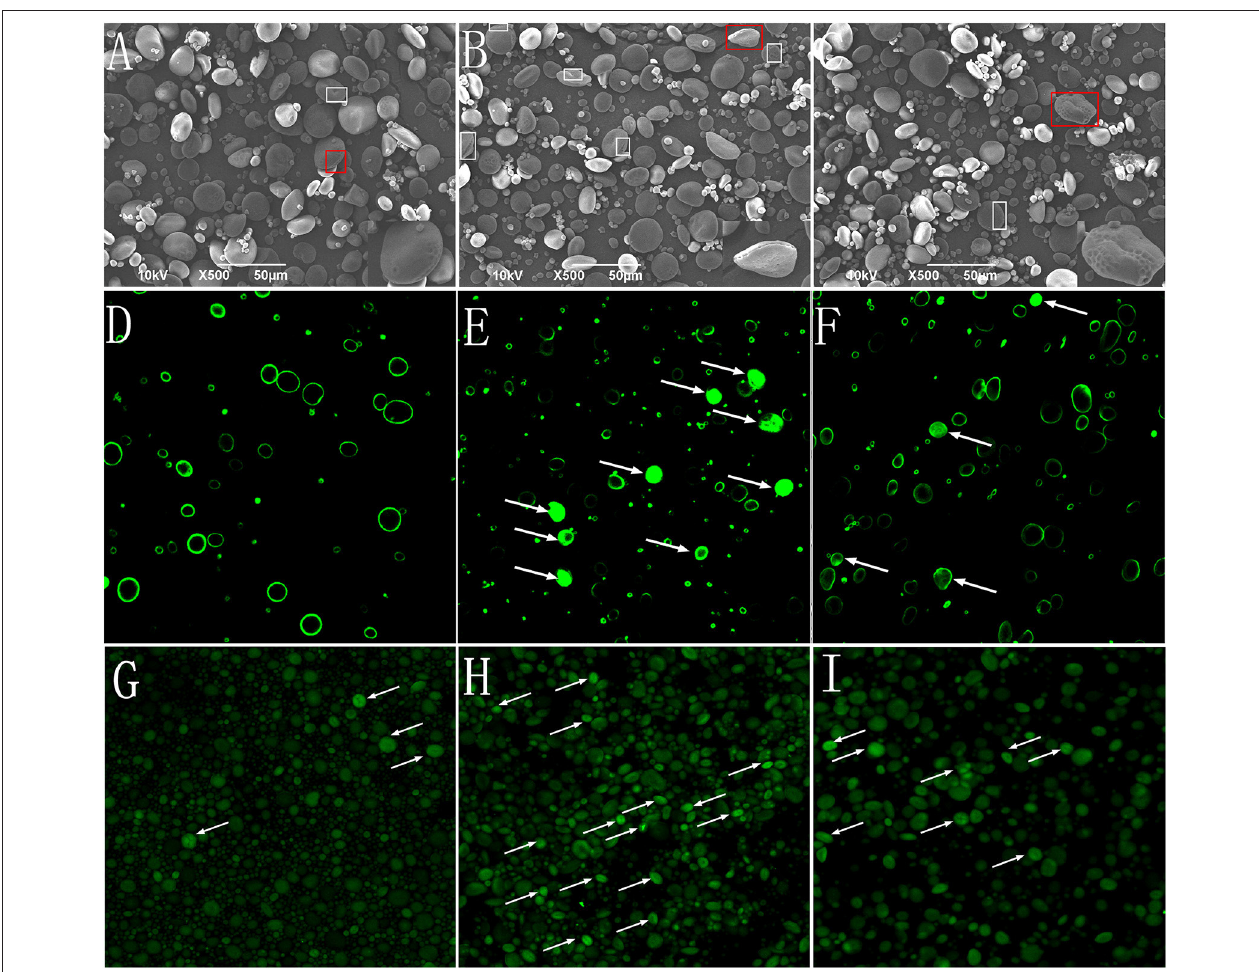
FIGURE 2 | Starch granules isolated from mature wheat seeds (35 days post anthesis) and observed using SEM ( × 500 magnification) and CLSM ( × 400 magnification). Starch granules were isolated from the wheat grain in the 0kg P ha − 1 (P0) treatment (A,D,G) , 46kg P ha − 1 (NP) treatment (B,E,H) , and 92kg P ha − 1 (HP) treatment (C,F,I) . (A–C) , starch granules observed using SEM; (D–F) starch granules stained with merbromin and then observed using CLSM; (G–I) starch granules stained with CBQCA and then observed using CLSM. The “pinholes” along the equatorial grooves and on flat surfaces of the granules were visualized with box. The magnified insets ( × 2,000) (A–C) were the starch in red box. Arrows indicate short channels and/or cavities (connected to the exterior by channels) (E,F) and radially oriented, channel-like, protein networks (G–I) within the